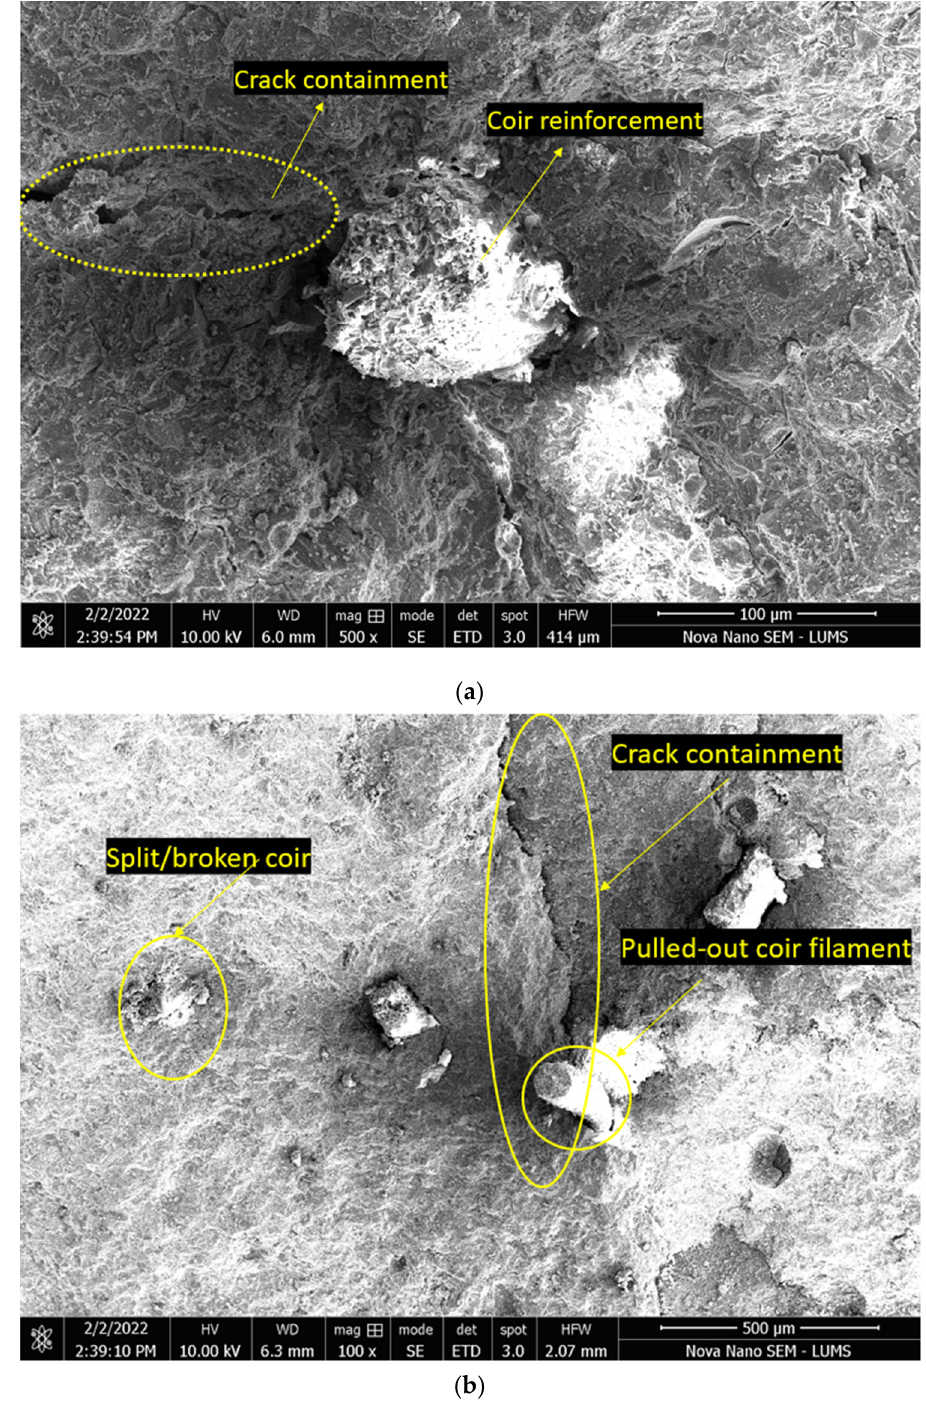
Figure 17. SEM image observations of coir embedded in the binder paste: ( a ) 100 µm; ( b ) 500 µm.